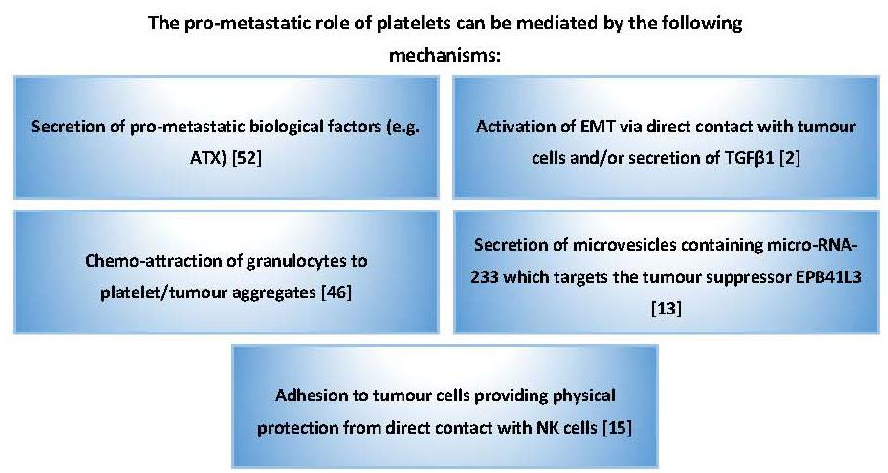
Figure 2. Summary of the pro-metastatic properties of platelets in cancer. Platelets promote cancer progression by releasing an array of pro-metastatic biological factors and by shielding cancer cells from NK-mediated cytotoxicity.